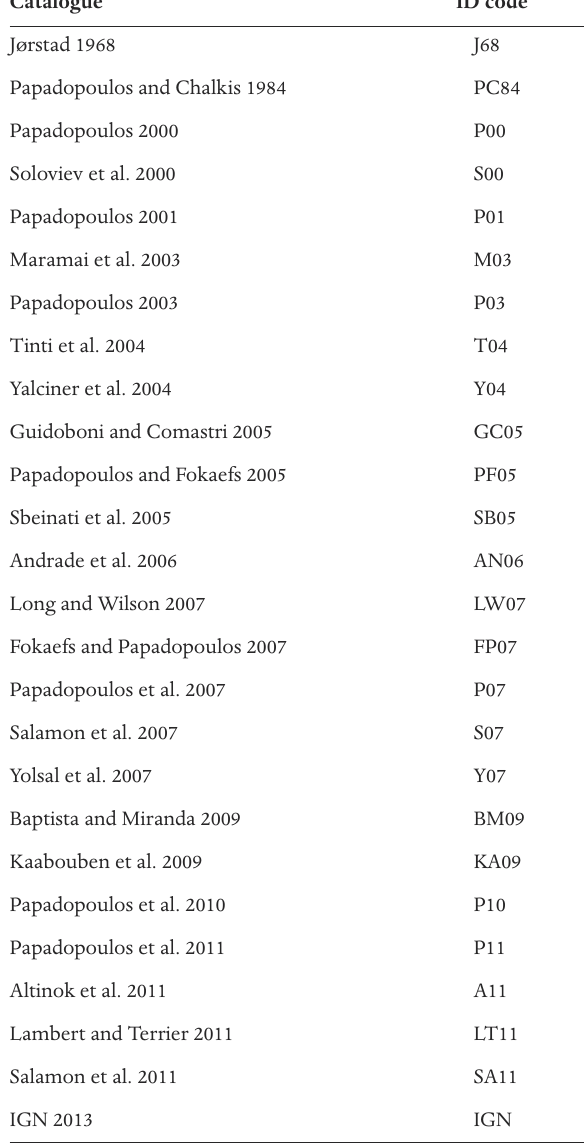
Table 1. List of the examined datasets. The acronyms “ID code” are used in Appendix